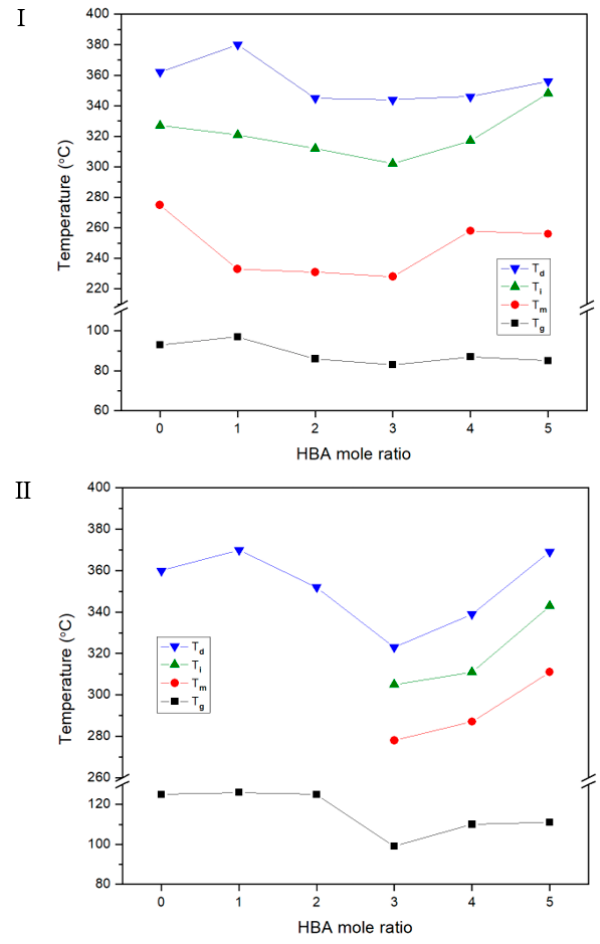
Figure 4. Thermal properties of TLCP-I and TLCP-II series with various HBA ratios.